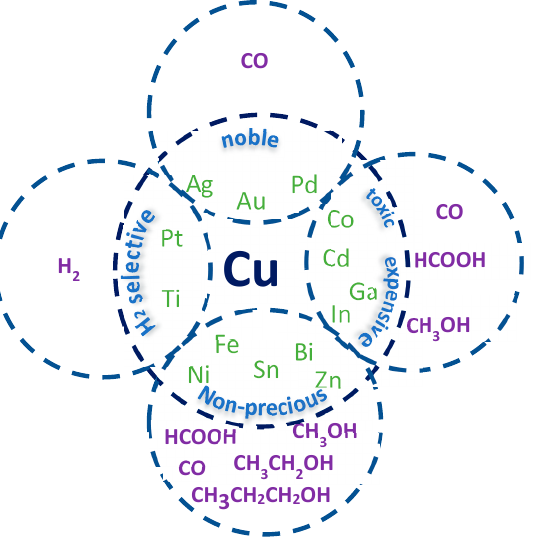
Figure 7. Scheme showing the different combinations of copper-based bimetallic catalysts so far reported in the literature for CO 2 reduction, with their characteristics and general selectivity.